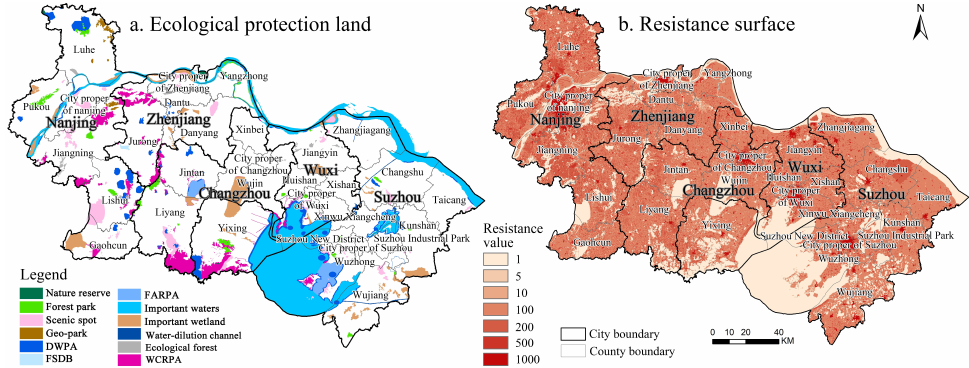
Figure 2. Ecological protection lands and resistance surface of southern